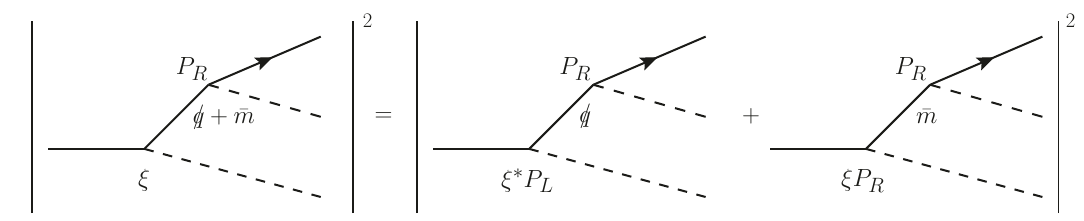
Figure 3 . CP asymmetry (cross term) from a single amplitude